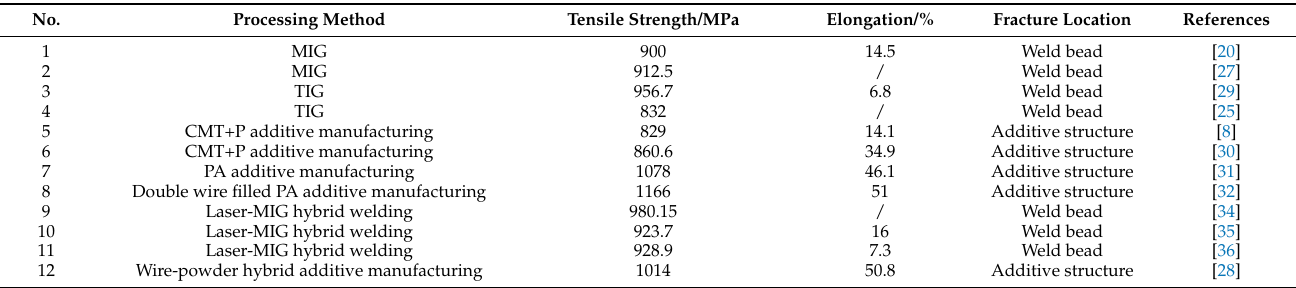
Table 1. Mechanical Properties of HNS welded structure.